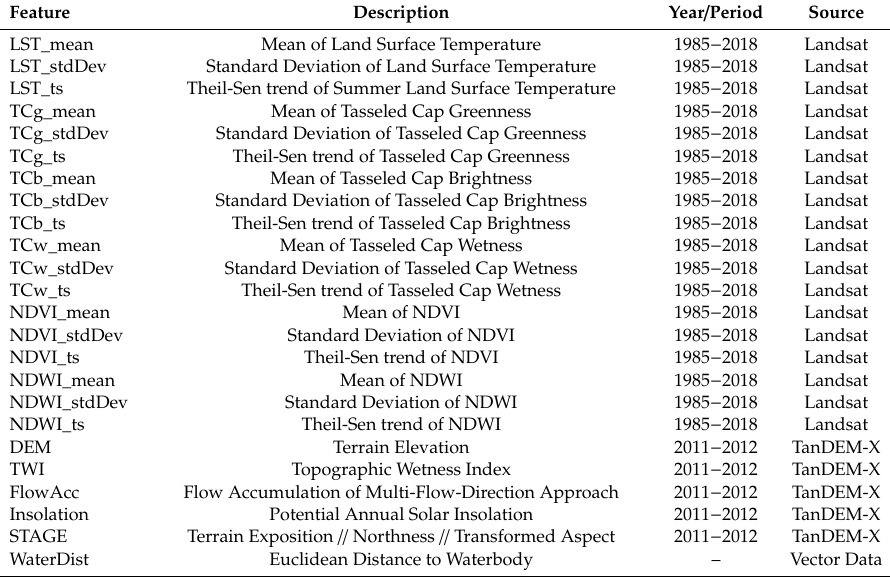
Table A2. Overview of the Landsat features derived in GEE and topography-related environmental factors derived from the TanDEM-X Digital Elevation